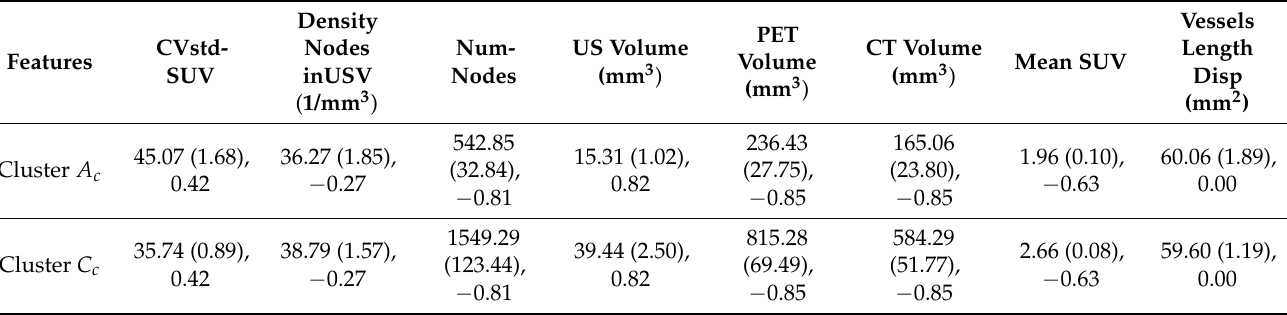
Table 2. Metabolic, vascular, and morphological characteristics of the clusters of the D con The average values of each parameter of each cluster are represented. In black, the mean values; in parenthesis, the standard mean errors; and in blue, the z-score